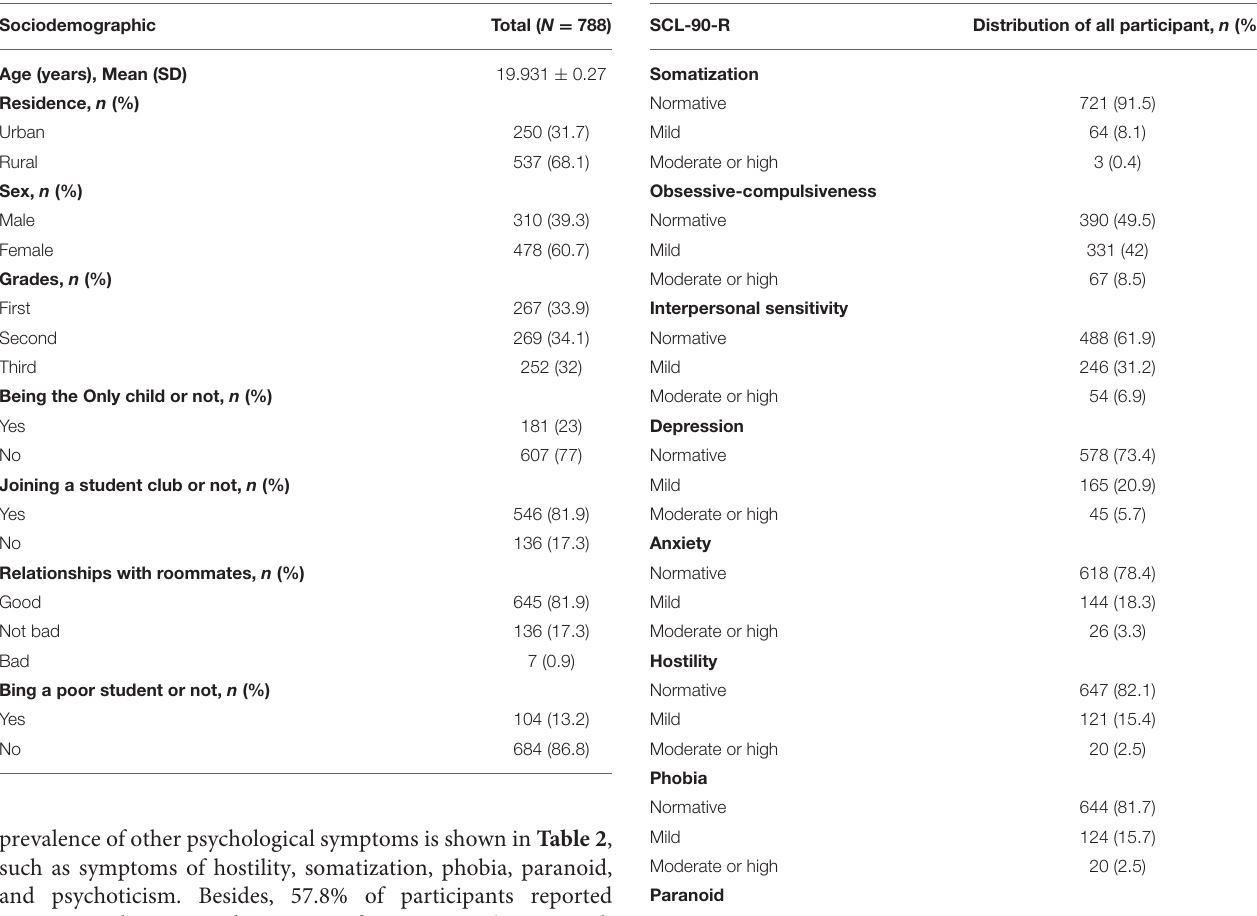
TABLE 1 | The study sample description ( N = 788). TABLE 2 | Distribution of